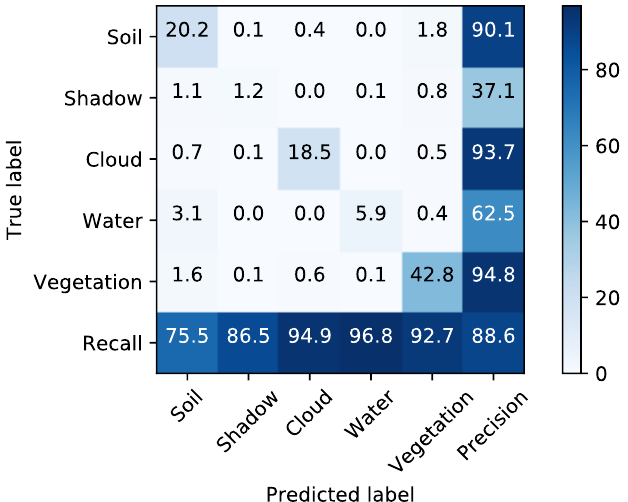
Figure 13. Confusion matrix of the proposed framework. The main diagonal indicates the pixel accuracy for each class in % for the ten selected